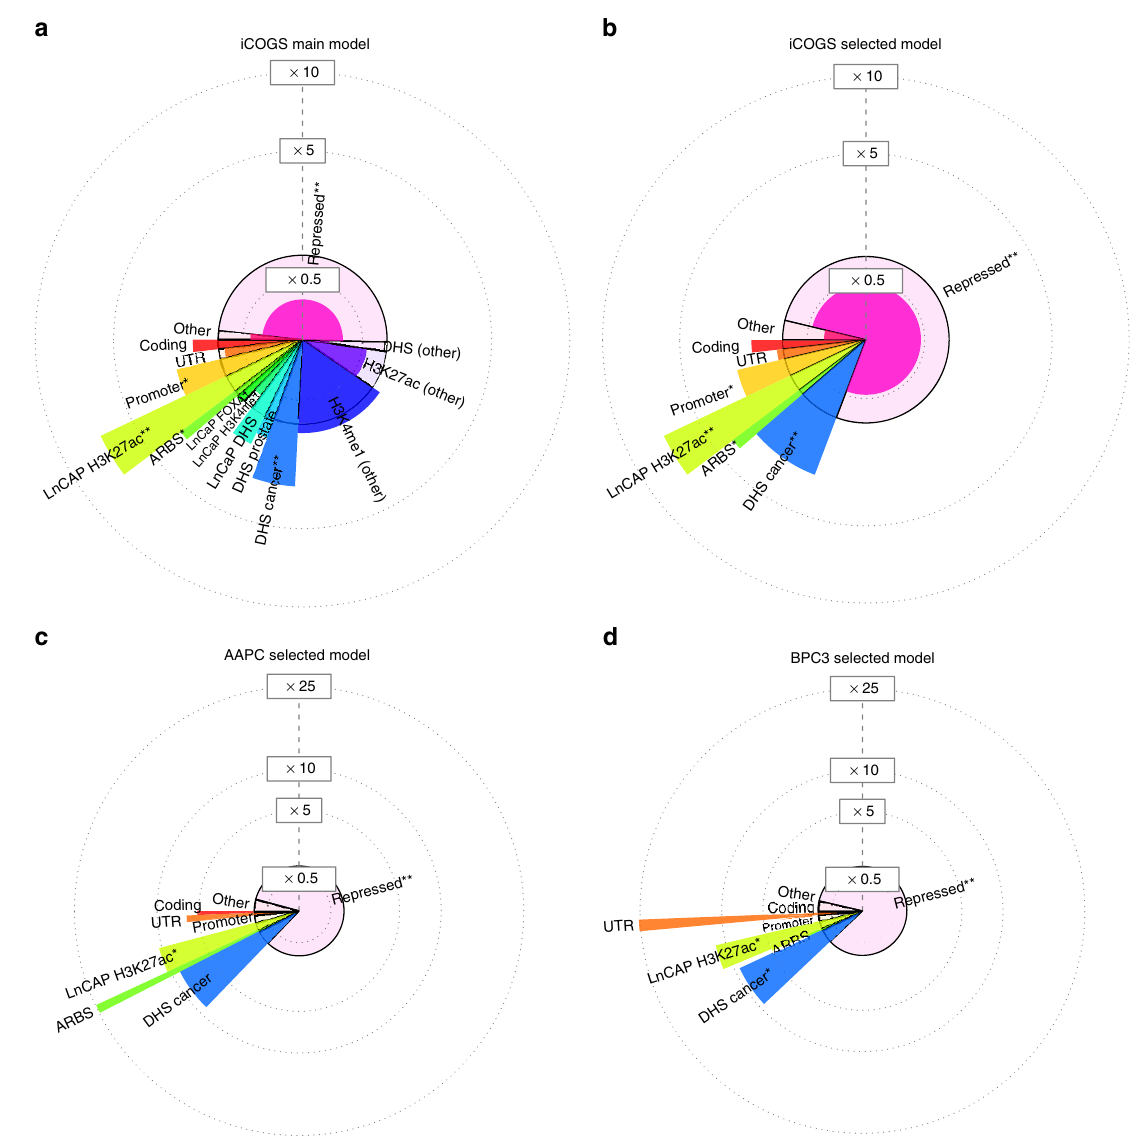
Figure 5 | Partitioning of heritability across functional classes in prostate cancer. Visual representation of heritability enrichment in three studies a , b : iCOGS; c : AAPC; d : BPC3 (shown numerically in Table 1). Each subplot corresponds to an analysis of the listed joint model, with coloured slices representing the functional annotations evaluated. Volume of each interior (light coloured) pie-chart slice represents the %SNP for the functional annotation, which is equal to the expected %h 2 under the null of no enrichment. Volume of each shaded pie-chart slice represents the actual %h 2 g inferred by the model. Slices extending outside/inside the middle pie correspond to enrichment/depletion in SNP heritability, as indicated by the dotted lines. Colour coding is consistent across all subpanels. * (**) denotes significant deviation at P o 0.05 ( P o 0.05/15) of fraction of SNP heritability ( %h 2 from null model of %h 2 % SNPs by Z -test; see Supplementary Table 6 for P g ¼